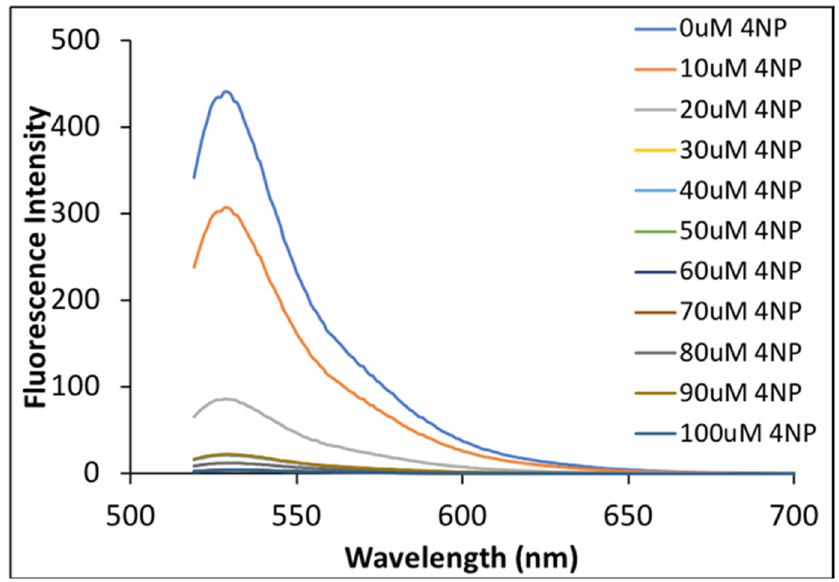
Figure 5. Fluorescence emission spectra of NaFl in the presence of different concentrations of 4NP in MeCN at an excitation wavelength of 510 nm.